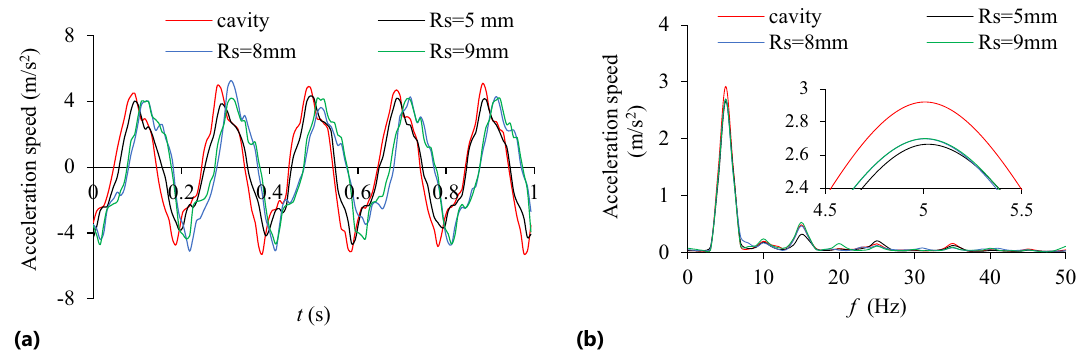
Figure 8. Acceleration speed of system n = 90 r/min: (a) Time-domain; (b) Frequency